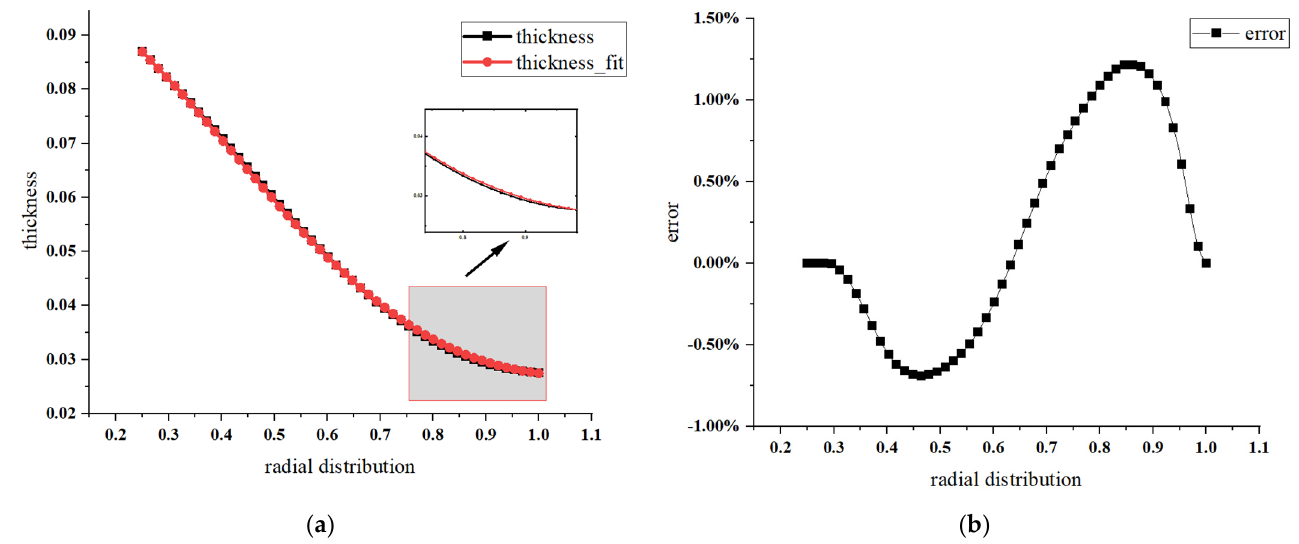
Figure 6. Comparison of pitch curve and pitch fitting curve: ( a ) curve comparison; ( b ) relative error.